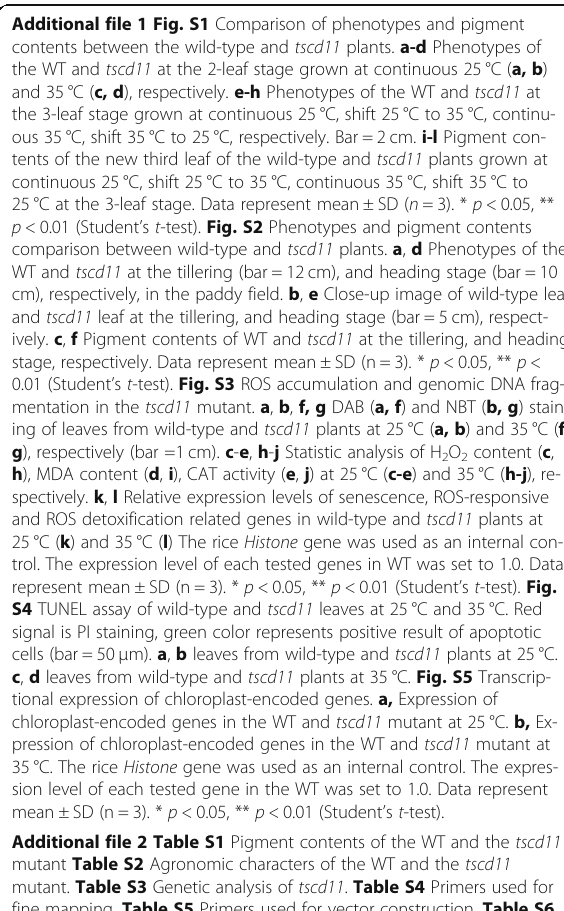
mutant. Table S3 Genetic analysis of tscd11 . Table S4 Primers used for fine mapping. Table S5 Primers used for vector construction. Table S6 Primers used for